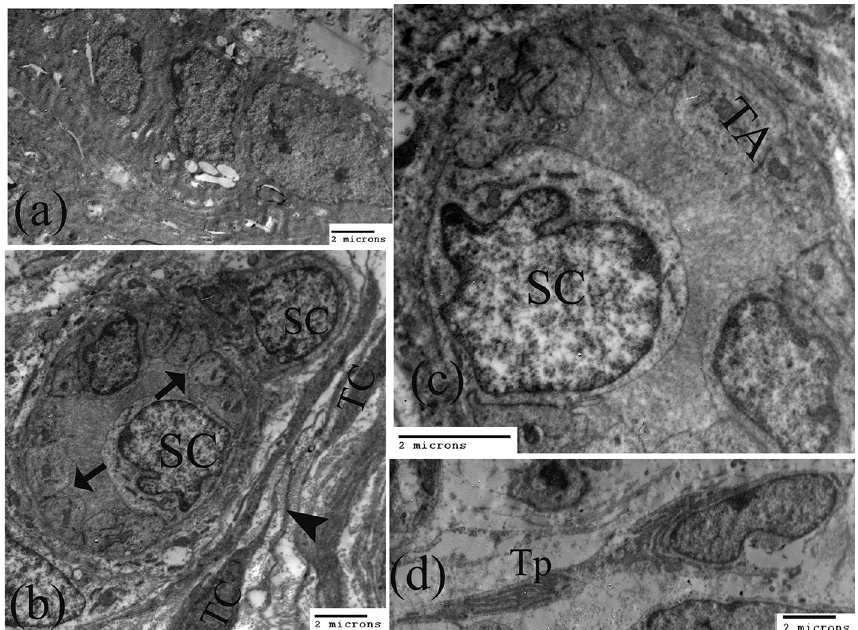
Figure 6. Transmission electron microscopy images showing ( a ) The basal limbal stem cells (LESCs), and ( b, c ) The limbal stromal epithelial stem cells clusters presented two types of cells, putative stem cells (SC) large cells characterized by high nuclear to cytoplasmic ratio with a large, indented nucleus, and populations of the transit-amplifying epithelial cells (TA)(arrow) small basal cuboidal cells hold a large nucleus with a prominent nucleolus. The limbal stromal epithelial stem cells cluster was enclosed by telocytes (TC) with long telopods (arrowhead). ( d ) The telocytes (TC) contain an indented oval nucleus bounded by a thin layer of cytoplasm and have long telepods (Tp) packed with